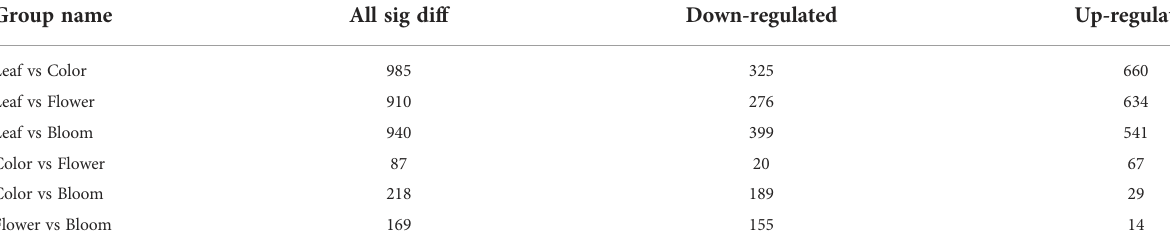
TABLE 1 Summary of the number of differentially accumulated metabolites among